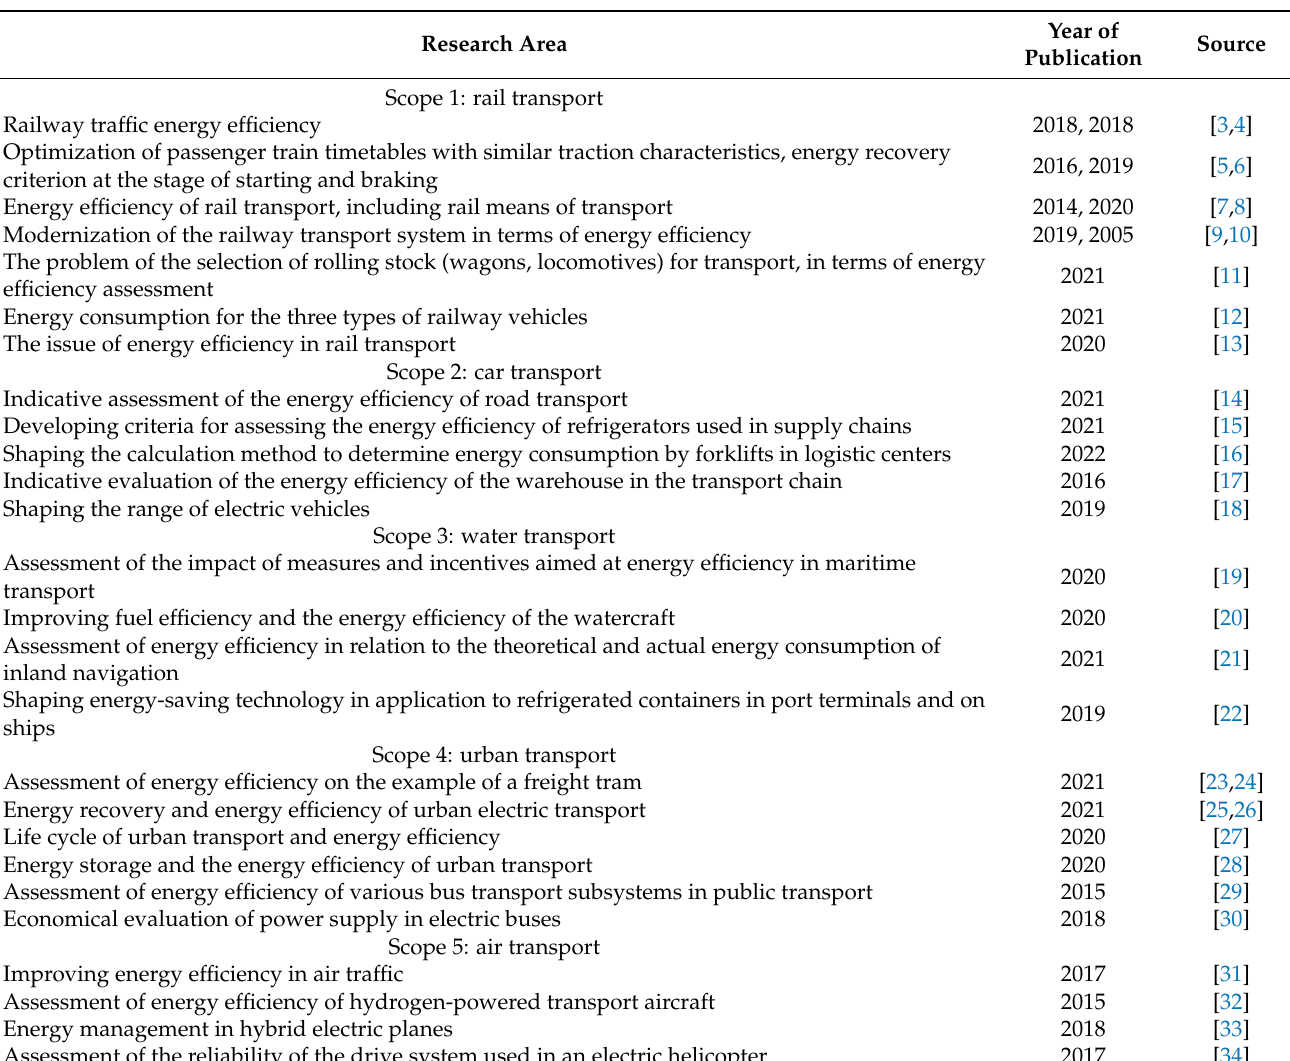
Table 1. Energy efficiency in transport; literature analysis.